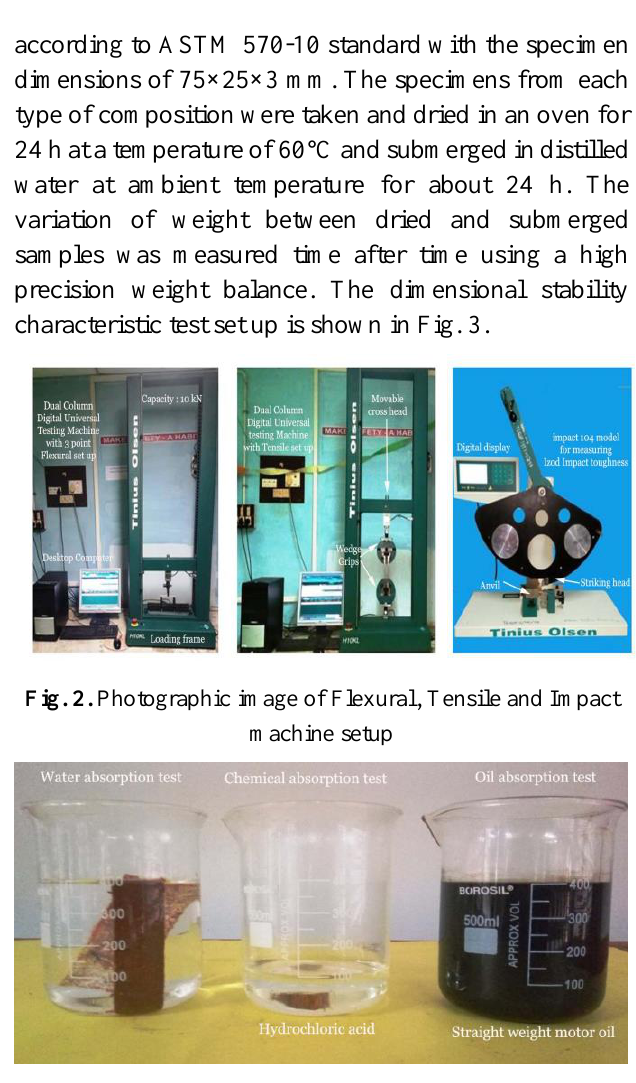
Fig. 3. Photographic image of dimensional stability characteristic test set